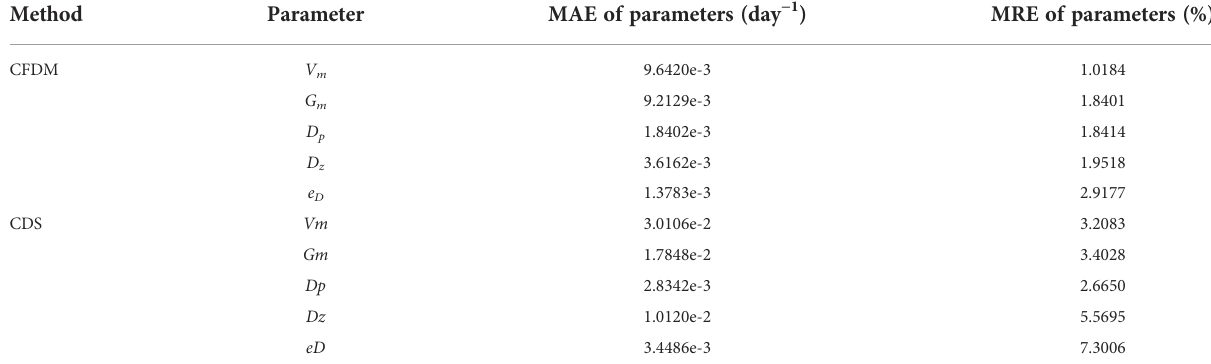
TABLE 7 Same as Table 5 , but for the experiment of Case 5 with 30% observation